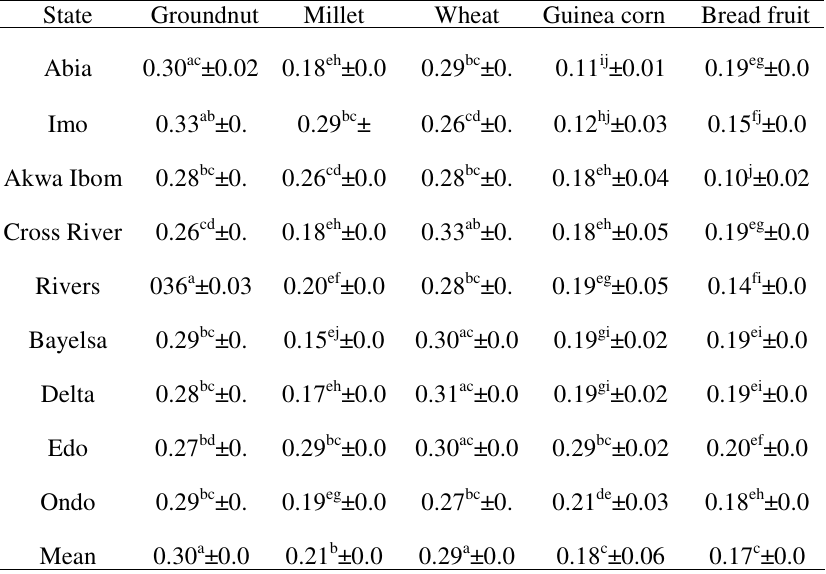
Values are mean ± S.D of three determinations. Values not sharing common superscript letter (s) in a column are significantly different at